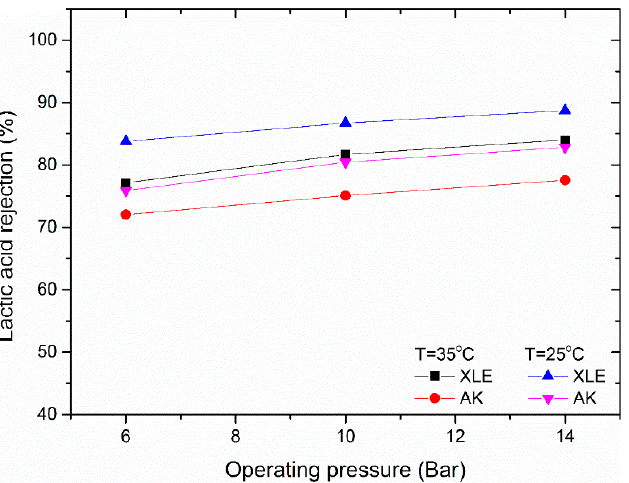
Figure 7. Effect of operating temperature on lactic acid rejection. Feed solution 0.9 ± 0.1 g/L of lactic acid and pH of 2.85.